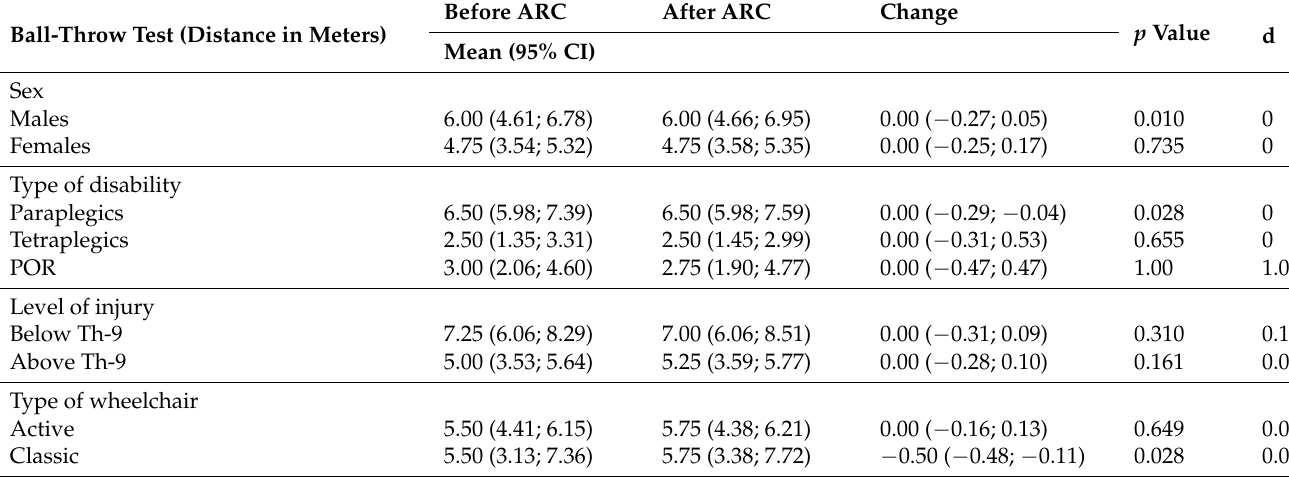
Table 4. The results obtained in the ball-throw test by the study participants before and after ARC.